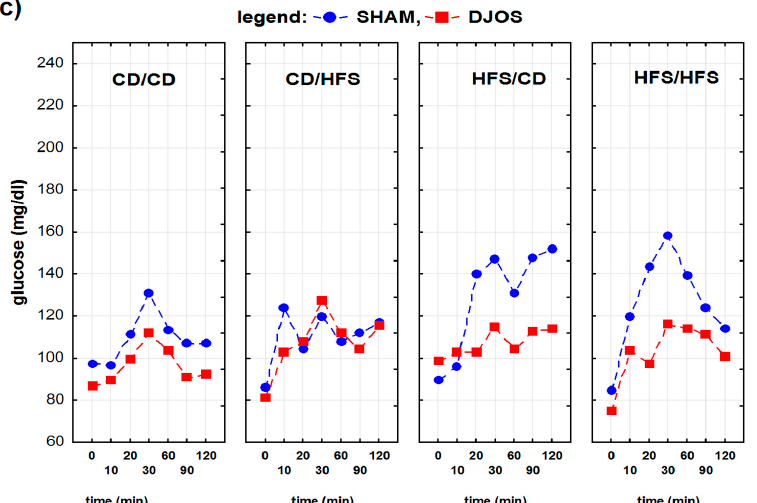
Figure 2. The oral glucose tolerance test (OGTT) results of Sprague–Dawley rats subjected to control (SHAM) and duodenojejunal omega switch (DJOS) surgery and different dietary regimes: ( a ) 8 weeks before the surgery, ( b ) 4 weeks after the surgery, ( c ) 8 weeks after the surgery. Legend: CD—control diet, HFS—high fat, high sugar diet, CD/CD—rats fed with CD diet before and after surgery, CD/HFS—rats fed with CD diet before but with HSF diet after the surgery, HFS/CD—rats fed with HFS diet before but CD diet after the surgery, HFS/HFS—rats fed with HFS diet before and after the surgery.